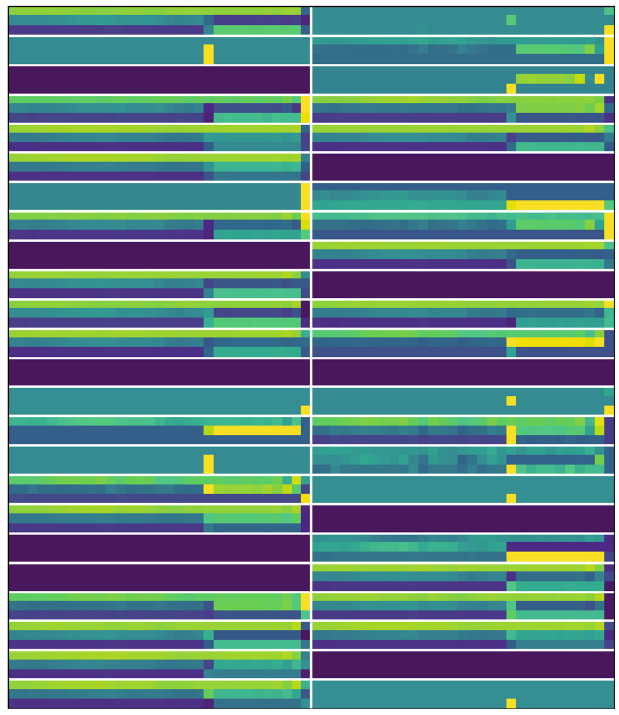
Figure 15: Feature visualization of the fi rst convolution layer (48 in